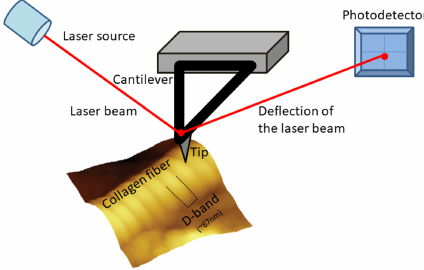
Figure 1. An illustration of an Atomic Force Microscopy scanning a collagen